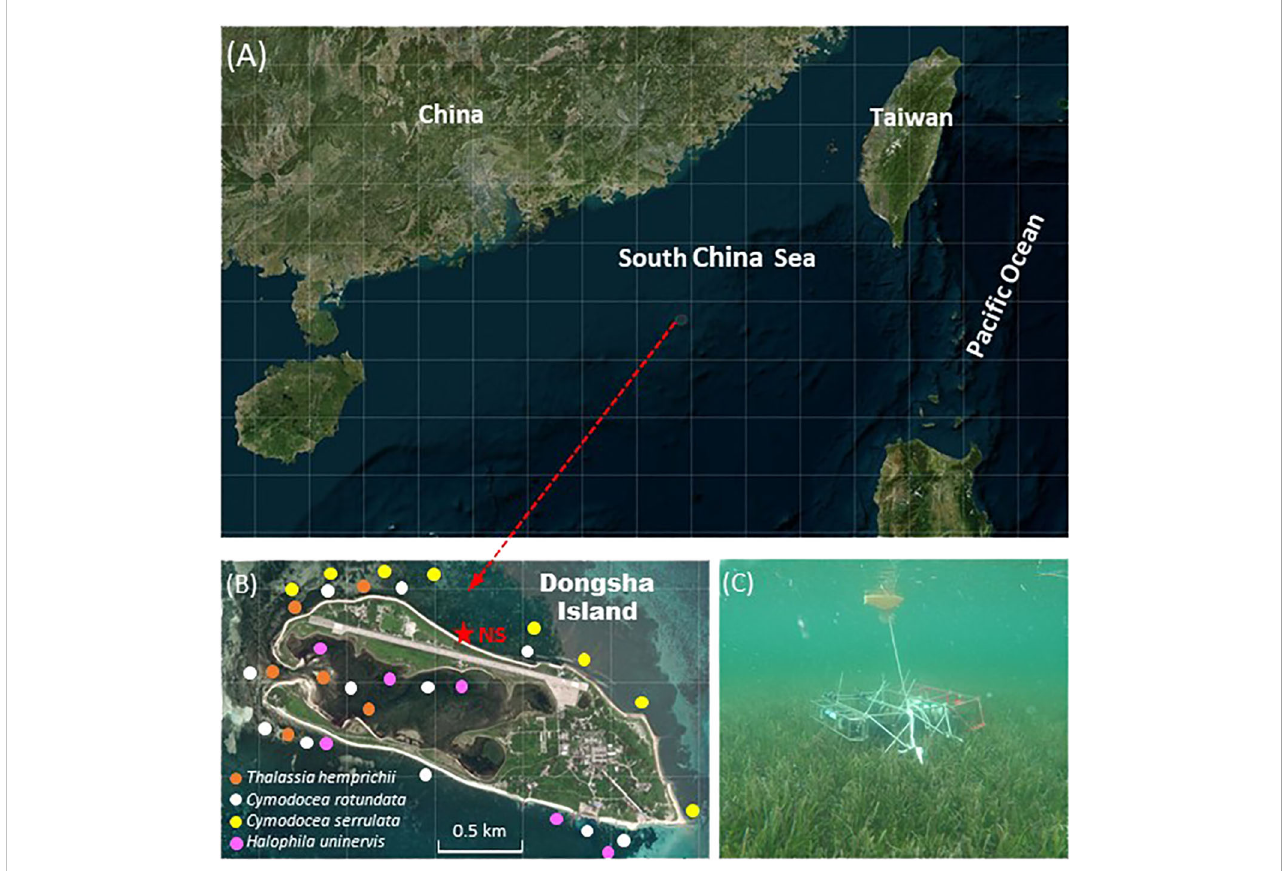
FIGURE 1 Map showing (A) the location of Dongsha Atoll, (B) the distribution of dominant seagrass (studies by Lin et al., 2005) and the study site on the northern shore of Dongsha Island (NS, asterisk), and (C) a photo of the sensors deployed within the seagrass